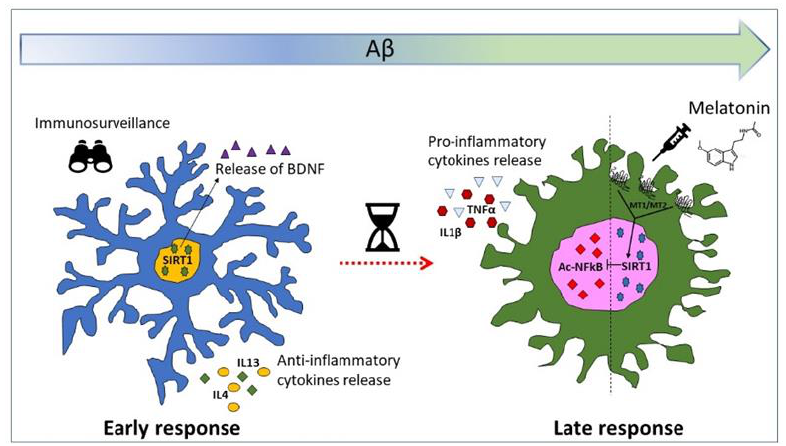
Figure 7. Dual response of microglia to Aβ challenge.